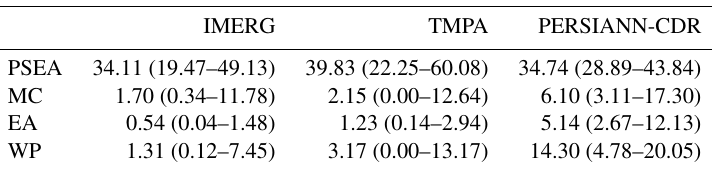
Table 2. Statistics for accumulated precipitation along trajectories (APT, mm) for peninsular Southeast Asia (PSEA), the Maritime Continent (MC), East Asia (EA), and the West Pacific (WP), calculated with IMERG, TMPA, and PERSIANN-CDR. Median values are presented along with the 25th and 75th percentiles provided in